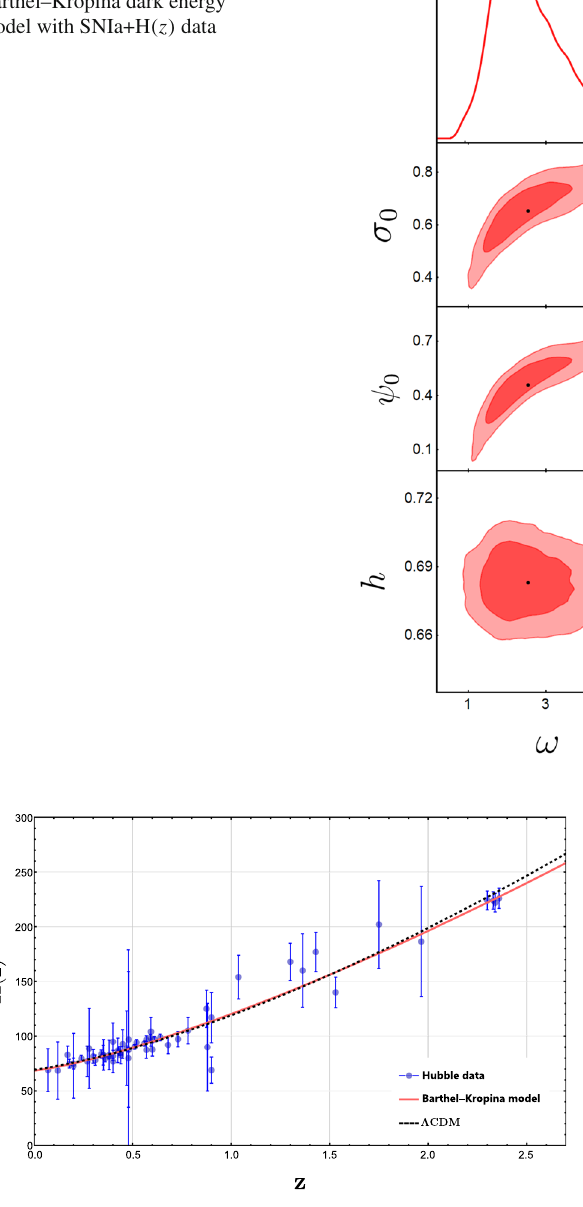
Fig. 2 The evolution of the Hubble parameter H ( z ) of the Barthel– Kropina and (cid:2) CDM models as a function of the redshift z against the Hubble measurements